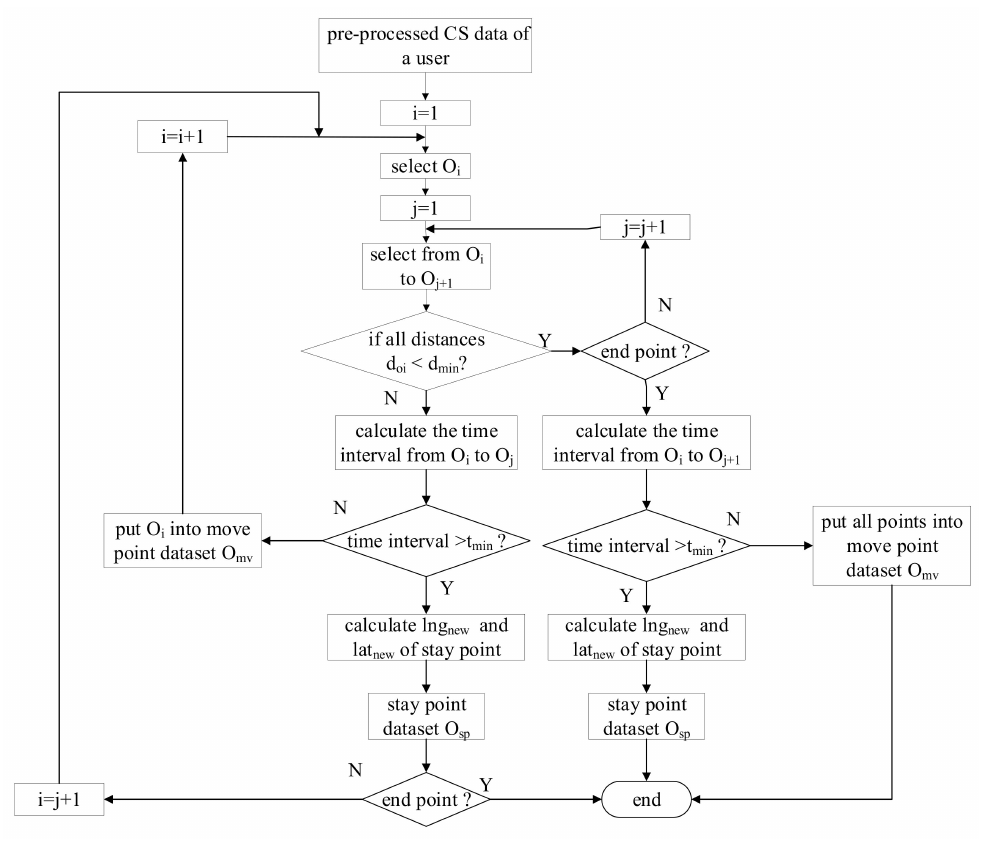
Figure 2. The flowchart of spatiotemporal clustering algorithm based on time allocation. In Figure 2, O i and O j+1 denote the ith and j + 1th point of user, respectively. d oi represents the distance from O i to potential stay point O. O mv is the move point dataset and O sp is the stay point dataset. The variables t min and d min are the time threshold